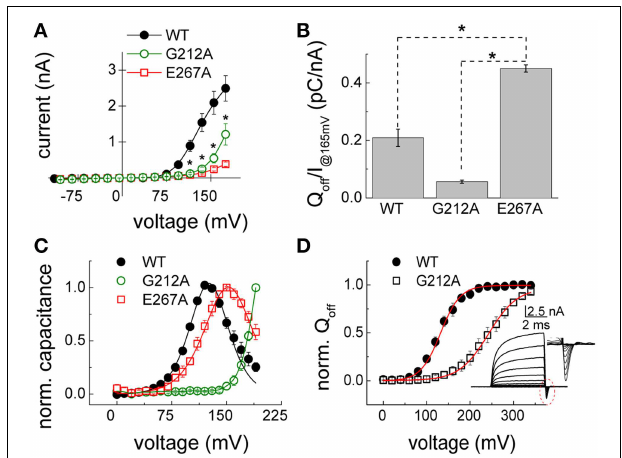
FIGURE 5 | Gating properties of the disease associated mutations G212A and E267A ClC-5. (A) Averaged current–voltage relations constructed by measuring the steady-state current amplitudes at the end of voltage steps in the indicated range as depicted in Figures 3D–F for cells expressing either WT ( n = 5 ), G212A ( n = 6 ) or E267A ( n = 11 ) ClC-5. Significant differences (for both mutants vs. WT ClC-5) at the level of 0.05 are indicated as stars. (B) Ratio between the off-gating charge (Q off ) and ionic currents (I) at + 165mV [ n = 5 . 11 , same cells as in (A) ]. Significant differences at the level of 0.05 are indicated as stars. (C) Voltage dependence of the non-linear capacitances of WT and G212A and E267A ClC-5 determined by using lock-in based impedance measurements. The curves for E267A and WT ClC-5 exhibit the typical bell-shaped form and were fitted with the first derivative of a standard Boltzmann function with the peak corresponding to the half-maximal activation (E267A ClC-5 - V 0 . 5 = 153 ± 2 mV, n = 5 ; WT ClC-5 - V 0 . 5 = 128 ± 2 mV, n = 5 ). The curve for mutation G212A did not exhibit a peak within the investigated range and was not fitted. (D) Voltage dependence of the activation of mutation G212A WT as obtained from gating current measurements. The inset depicts a representative recording from WT ClC-5 measured with short pulses. The encircled region is additionally depicted enlarged to show the off-gating currents that were integrated to obtain the gating charge Q off . The red lines represent Boltzmann fits to the data to obtain the half maximal voltage of activation (G212A and WT ClC-5, respectively, V 0 . 5 = 240 ± 10 mV, n = 4 and V 0 . 5 = 132 ± 6 mV, n = 4